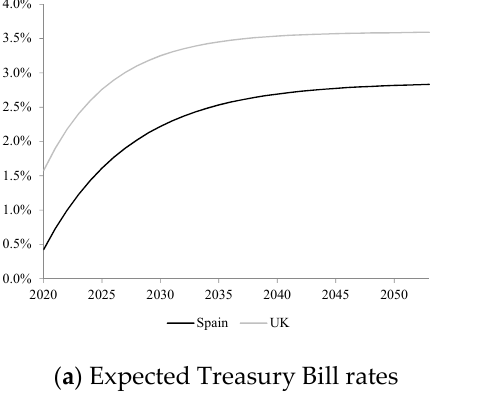
Figure 3. Expected Treasury Bill rates and equity risk premiums.